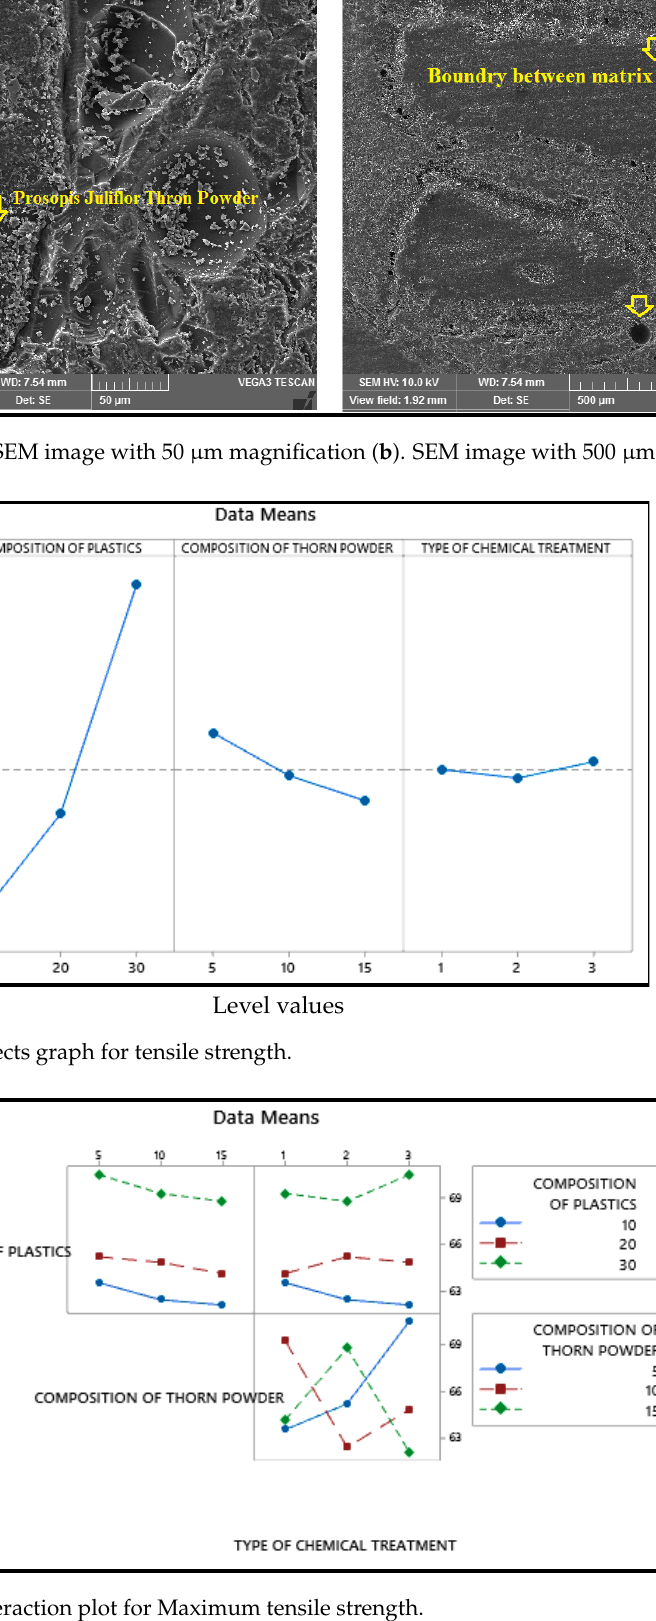
Figure 11. Interaction plot for Maximum tensile strength.